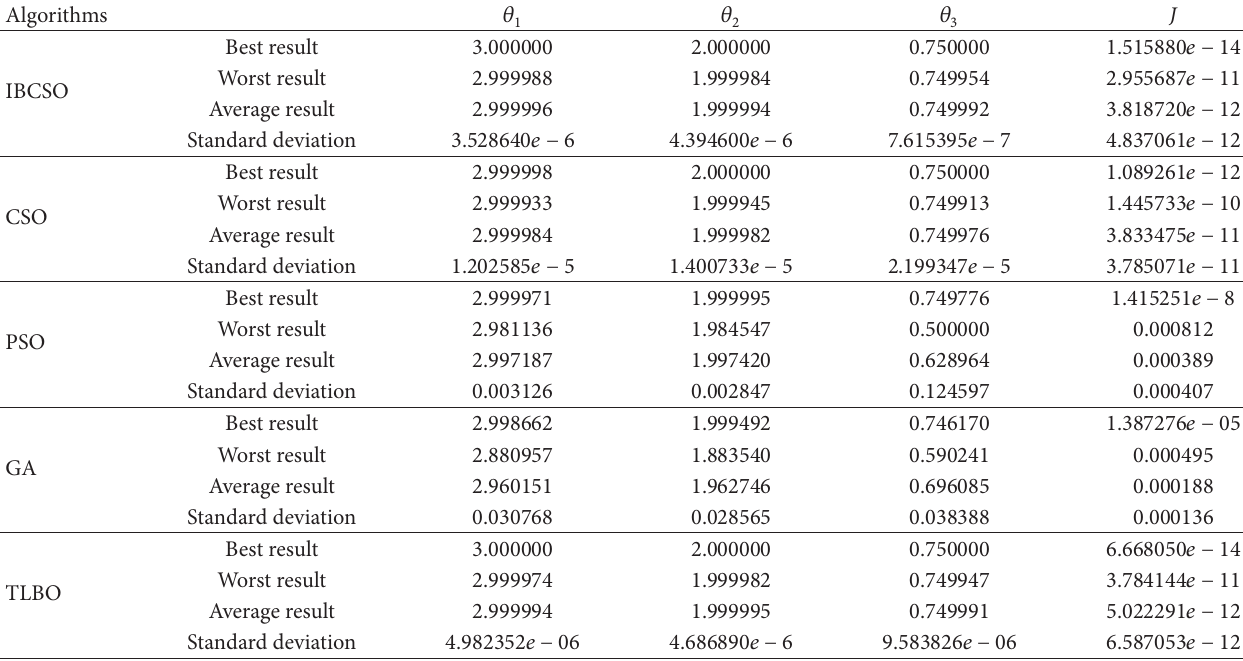
Table 4: Statistical results from the IBCSO, CSO, PSO, GA, and TLBO.